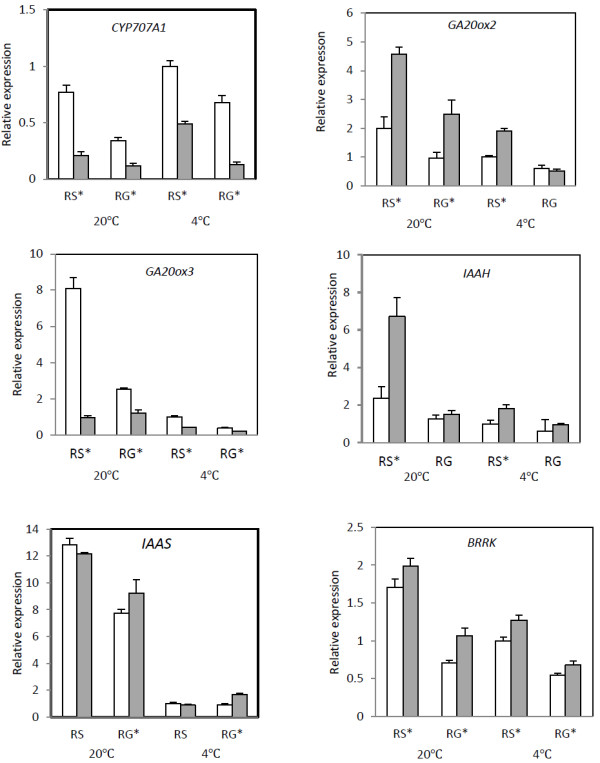
Relative expression levels analysis of transcripts positively associated with dormancy release (CYP707A,GA20ox2, GA20ox3, IAAH, IAAS, BRRK,) in the Embryo (Em□) and endosperm (En■) under warm (20°C)/cold (4°C) seed stratification processes. RS, radical just sprouted; RG, radical growing up to 1.5 cm. Expression is shown relative to GAPDH as the reference gene. RNA was extracted from three biological samples and qRT-PCR was performed. Data represent means ± SD. * indicate a significant difference between Em and En at P < 0.05.